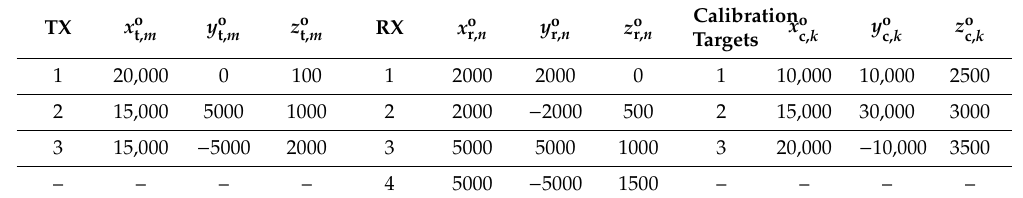
Figure 2. Localization scenario geometry for simulation. Table 1. Positions (in meters) of the transmitters, receivers and calibration targets.